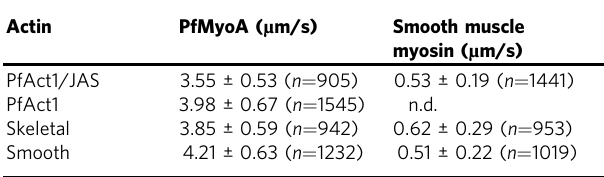
Values are mean ± SD. Two separate experiments were performed for each condition. Each pairwise combination of a given motor with different actins is statistically insigni fi cant using a two-sided z- test. All PfMyoA/actin pairs, p ≥ 0.416; all smooth muscle myosin/actin pairs, p ≥ 0.774 (PfMyoA/PfAct1/JAS vs. PfMyoA/PfAct1: p = 0.604; PfMyoA/PfAct1/JAS vs. PfMyoA/ skeletal: p = 0.704; PfMyoA/PfAct1/JAS vs. PfMyoA/smooth: p = 0.416; PfMyoA/PfAct1 vs. PfMyoA/skeletal: p = 0.875;PfMyoA/PfAct1vs. PfMyoA/smooth: p =